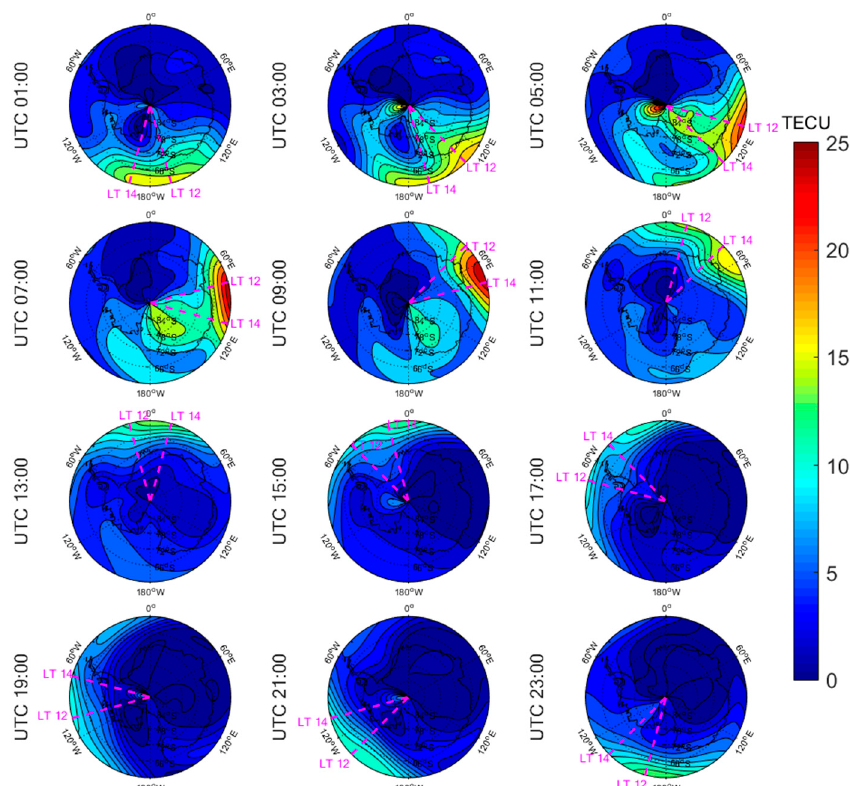
Figure 11. Spatial distribution of mapping TEC of 12 sections under high solar activity year, polar day (DOY 001 in 2014) over the Antarctic. The magenta lines in each subplot represent the longitudes at 12:00 and 14:00 at the middle of the 2 h section of the corresponding subplot.